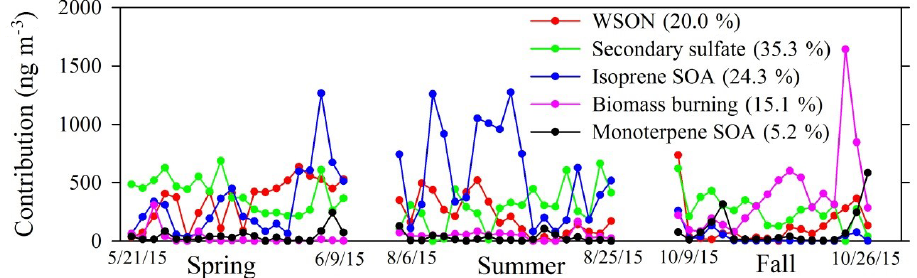
Figure 6. Time series of factor contributions to WSOC (mean factor contribution shown in